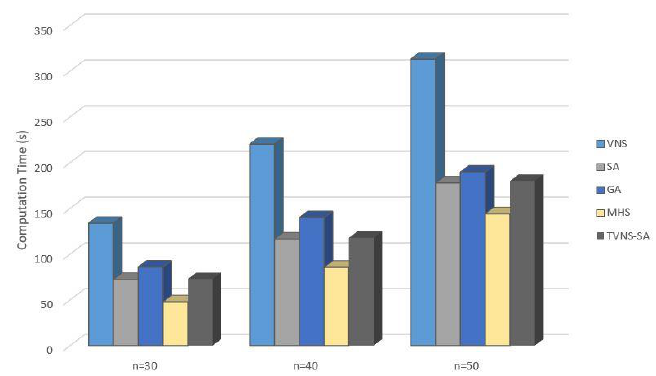
Figure 15. Computational CPU running times for algorithms.